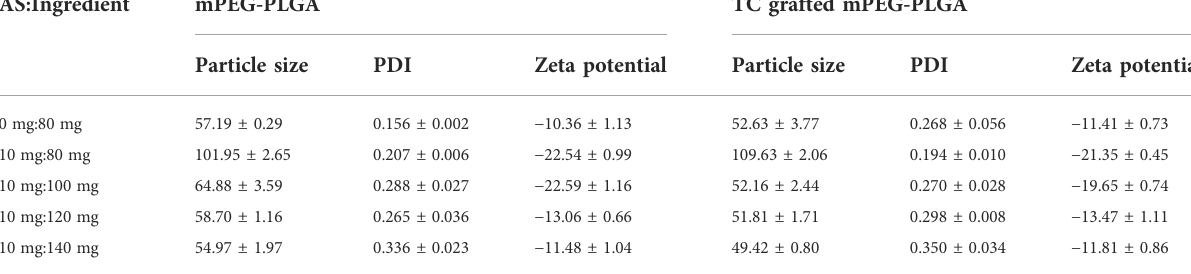
TABLE 1 The particle size, PDI and zeta potential of different ratio of AS-loaded in mPEG ‒ PLGA or TC grafted mPEG ‒ PLGA ( n = 3).